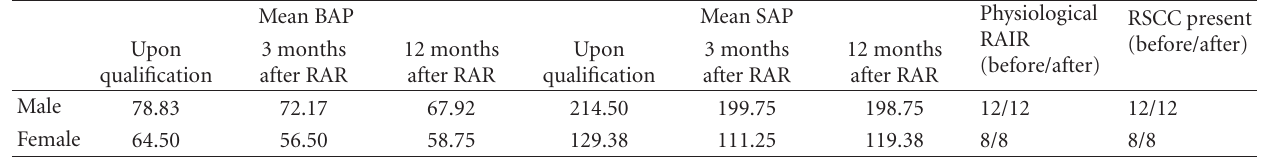
Table 2: Manometric findings upon qualification and 3 months after DGHAL-RAR